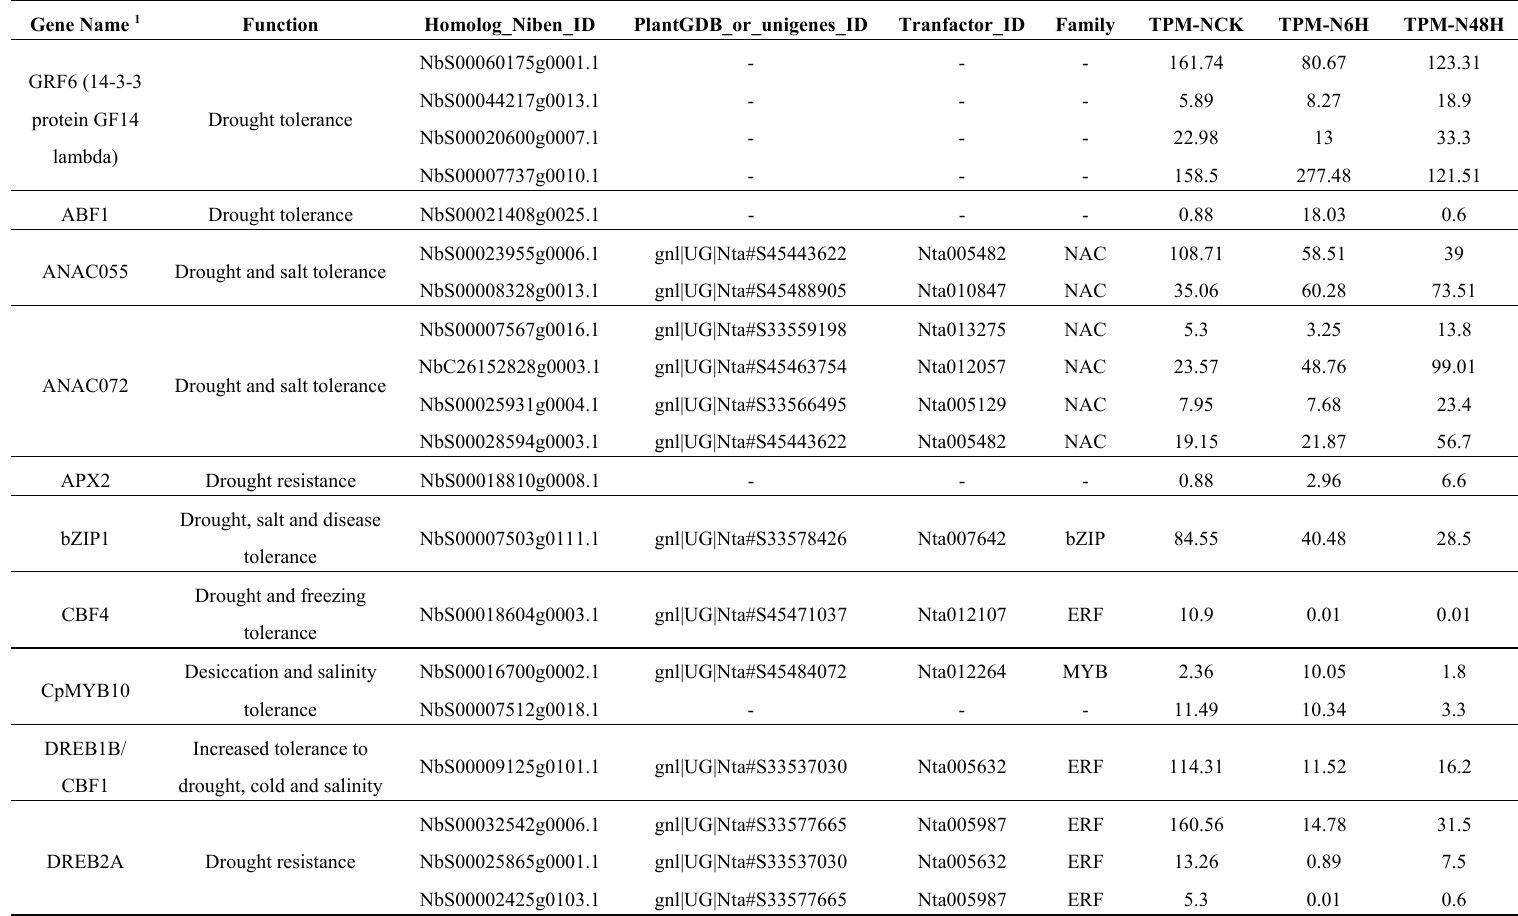
Table 1. Possible drought responsive genes (DRGs) with different expression in tobacco